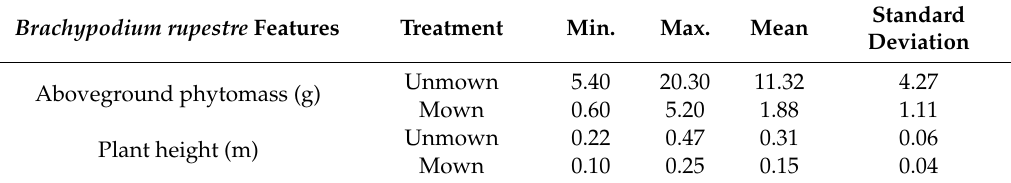
Standard Deviation